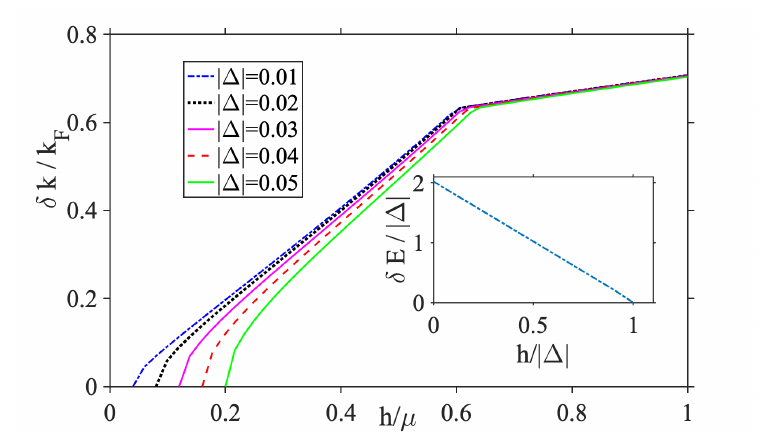
Figure 7: Magnetic field-driven phase transition. The separation between each pair of nodal points increases as we increase the in-plane field beyond the superconducting pairing ∆ . This is shown for a range of ∆ s. The inset shows that the spectral gap δ E decreases linearly with increasing h . This is true for all ∆ s. The spectrum becomes gapless at h = | ∆ | and continues to remain so for h > | ∆ |